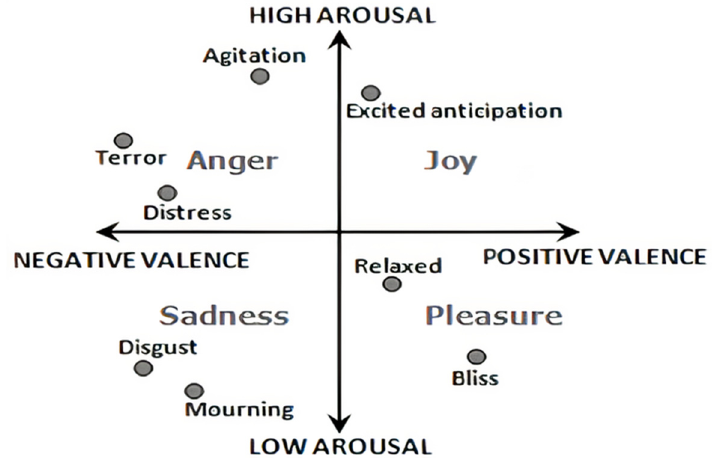
Figure 8. Illustration of 2D model based on valance and arousal (Rusell, 1976).